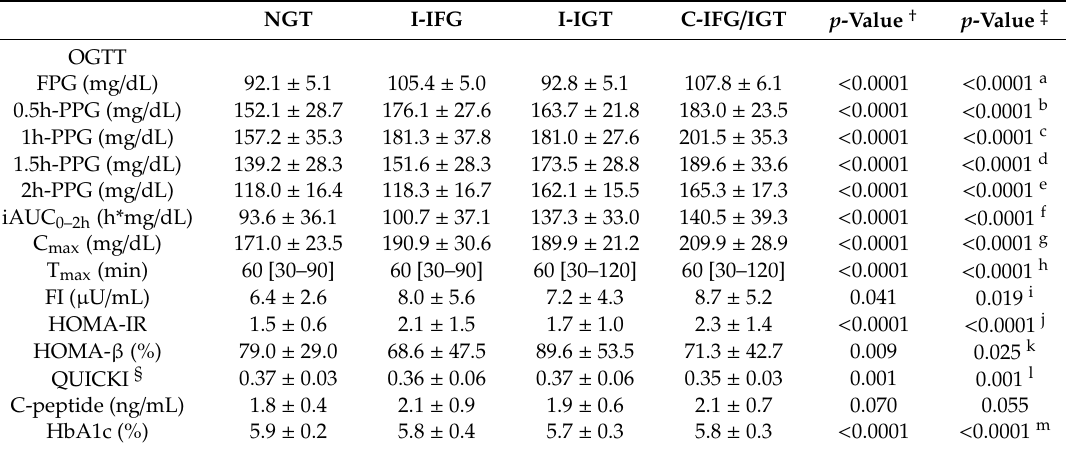
Table 2. Various parameters of dysglycemia among prediabetes